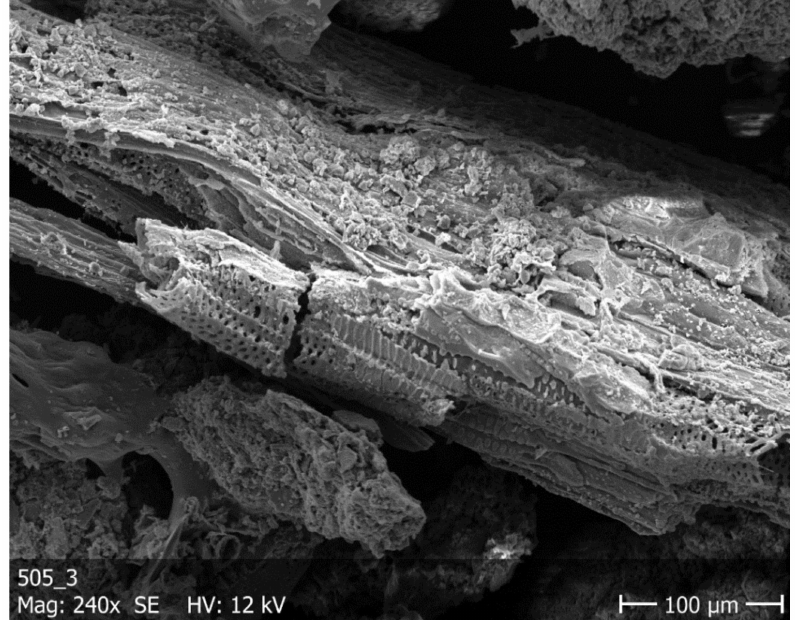
Figure 27. SEM micrograph of biochar derived from 50% wastewater sewage sludge and 50% anaerobic digestate. Ash content can be seen to be distributed on the biochar matrix. The BET surface area of this sample is 8.08 m 2